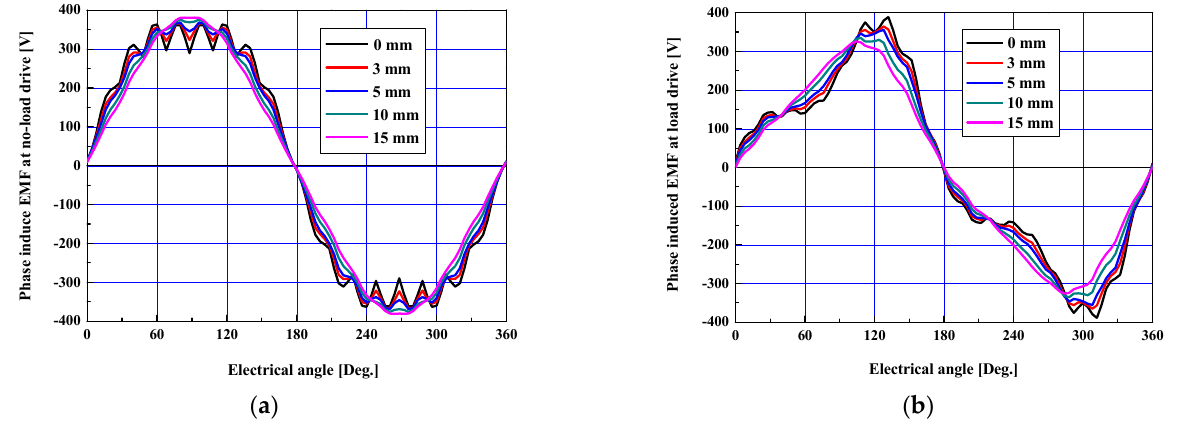
Figure 6. Wave form of the induced EMF according to the eccentricity: ( a ) no-load drive, and ( b ) load drive.